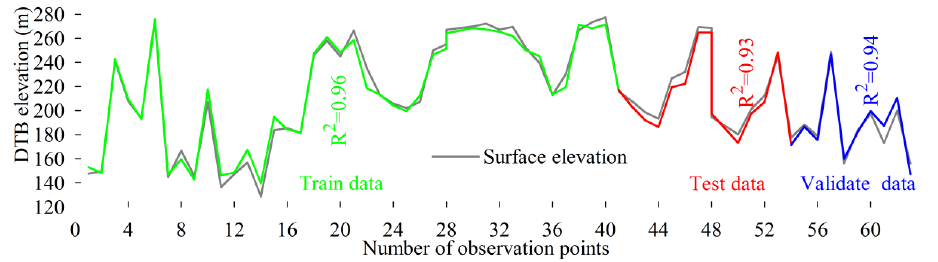
Figure 7. The ETs expression of selected optimum GEP model.